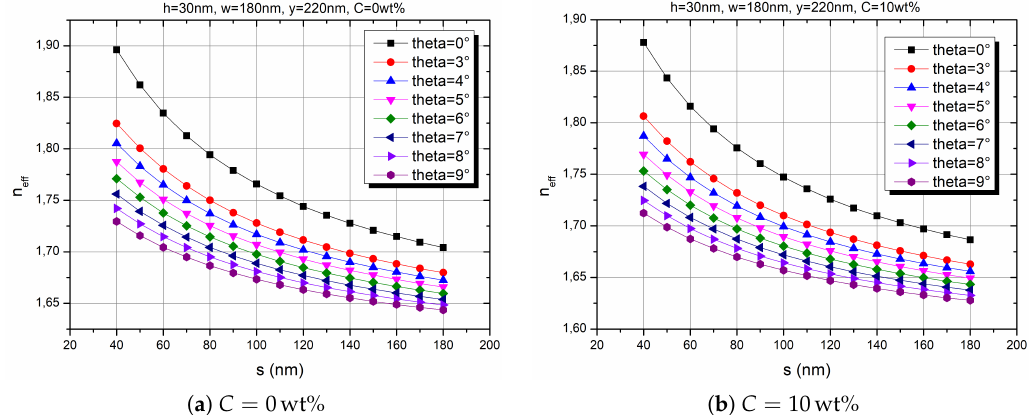
Figure A1. Effective refractive index n eff for both concentrations as a function of s and with θ as parameter.